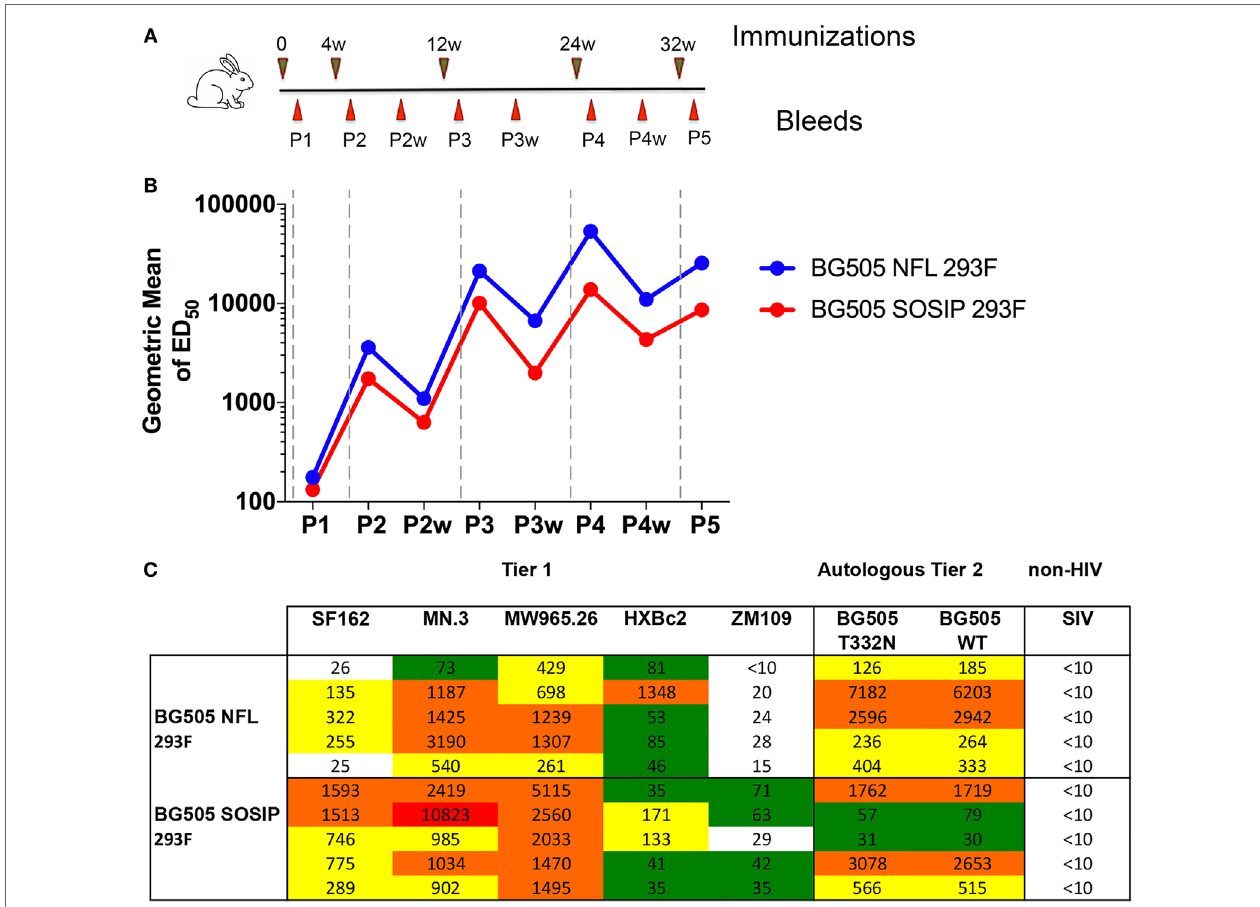
FigUre 6 | Comparison of neutralizing responses elicited in rabbits by BG505 NFL and BG505 SOSIP trimers. (a) Schedule of immunizations and bleeds. (B) Longitudinal analysis of BG505 NFL- or BG505 SOSIP-specific antibodies elicited in rabbits. The geometric mean of ELISA binding titers (ED 50 ) for all the animals is plotted against selected sampling bleed time points. Immunization events are shown as vertical dashed gray lines. (c) Neutralization ID 50 titers at final bleed point (P5) against a panel of tier 1 and tier 2 pseudoviruses. Data are representative of two independent